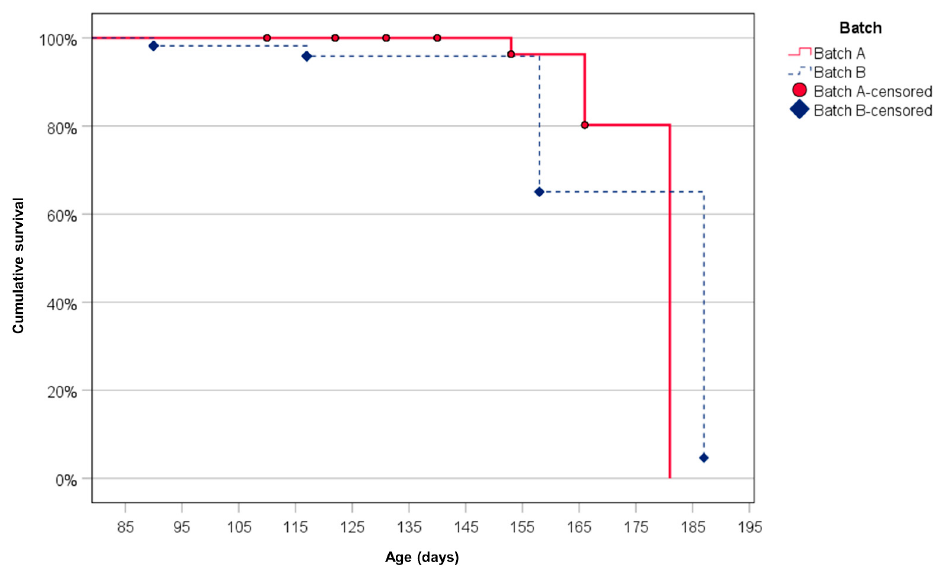
Figure 2. Kaplan–Meier survival curves for animals of the two batches. Censored animals are pigs remained HEV-RNA positives for the entire study period and animals of the batch A that lost the ear-tag or died (n = 4, lost at follow-up).